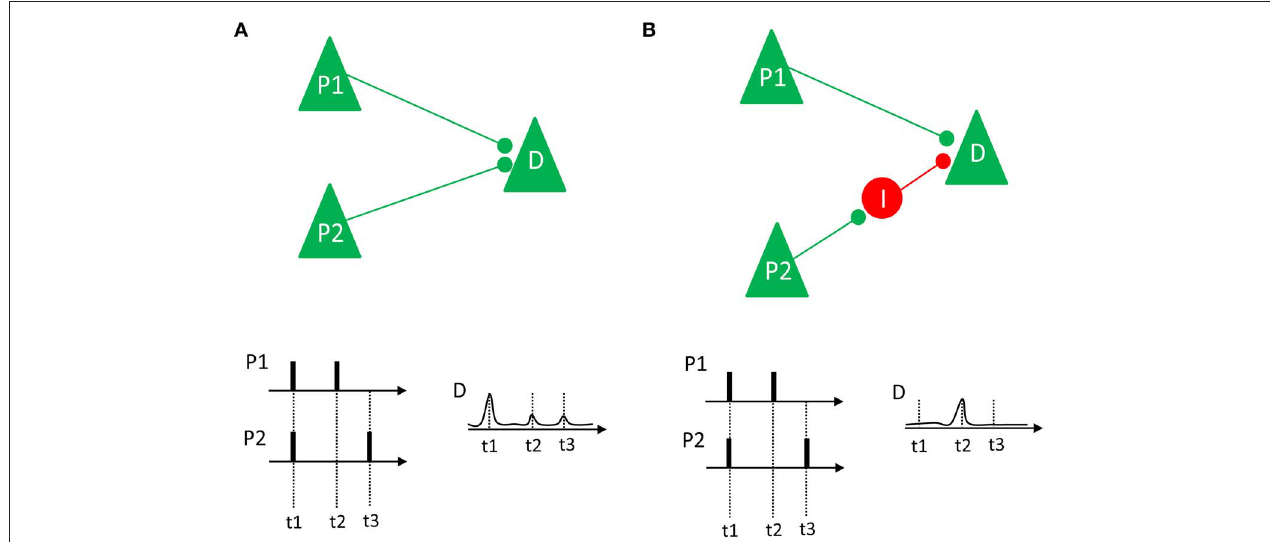
FIGURE 7 | Two different neural connection properties and their relation to synchrony and LTP are shown. (A) Two pyramidal neurons (P1 and P2) have excitatory projections to a down-stream neuron D. If these neurons fire in synchrony (as it happens at t1), their impact on the down-stream neuron adds up, thus increasing the likelihood of a discharge and LTP. If they fire asynchronously (t2 and t3) there is low probability that D will discharge